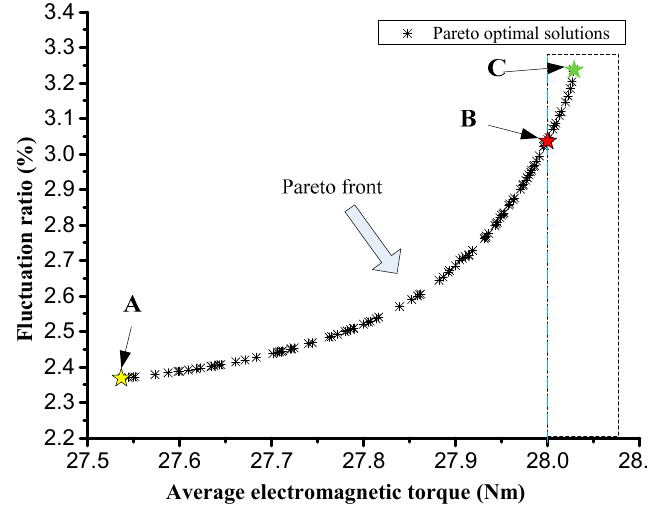
Figure 19. Pareto front of two optimization objectives. Table 5. Optimum design parameters and objective functions.